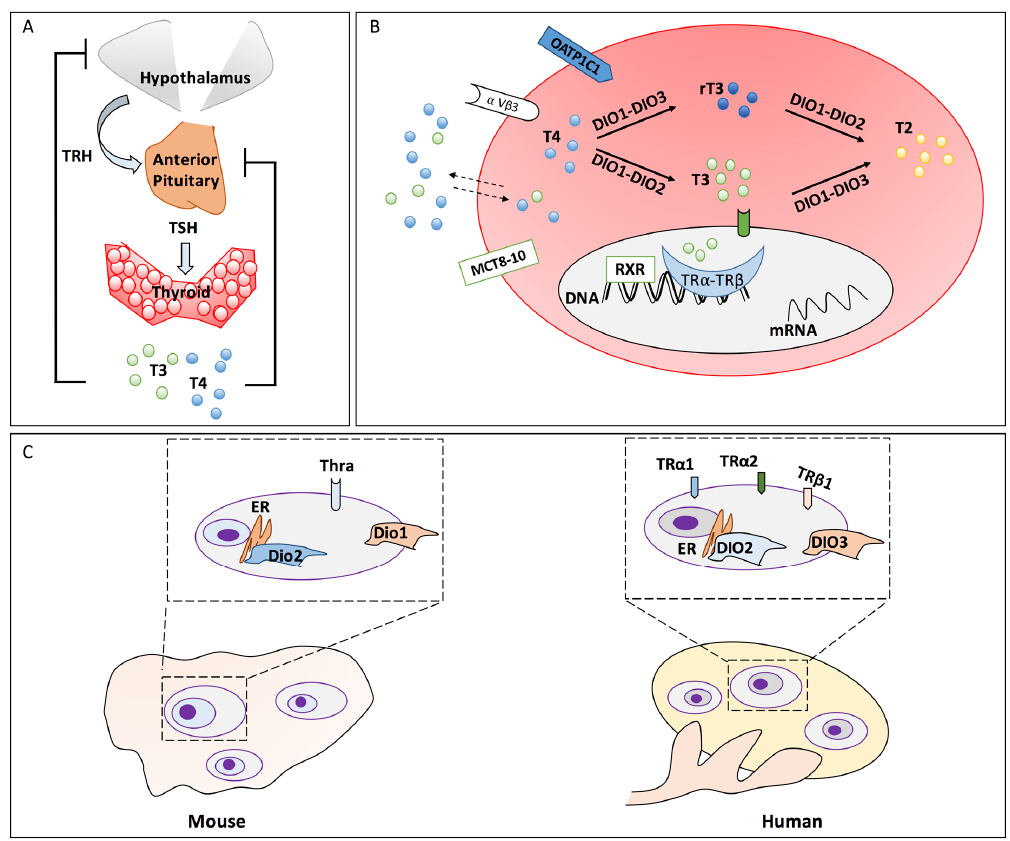
Figure 1. HPT-axis and peripheral TH metabolism / signalling in mammals. ( A ) Hypothalamic-Pituitary-Thyroid (HPT)-axis and its regulatory feedback loops. ( B ) Mechanisms/enzymes and other proteins involved in the cell/tissue-specific TH metabolism and signalling. ( C ) Description of the species-specific pattern of the ensemble of proteins involved in TH metabolism and signalling in the ovary. The ovarian follicles are evidenced in the dashed rectangles. The zoom on a single follicle is reported in the upper dashed box in order to evidence the ensemble of the expressed proteins involved in peripheral TH metabolism and signalling. Abbreviations: TRH, thyrotropin releasing hormone; TSH, thyroid-stimulating hormone; T4, thyroxine; T3, triiodothyronine; T2, 3,5-diiodo-L-thyronine; rT3, reverse triiodothyronine; DIO1, DIO2, DIO3, deiodinases; MCT8–10, monocarboxylate transporter 8–10; OATP1C1, organic anion transporting polypeptide 1C1; α V β 3, integrin alpha (V) beta (3); TR α and TR β , thyroid nuclear receptors isoform α , β ; RXR, retinoic acid X receptor; ER, endoplasmic reticulum; Thra, thyroid hormone receptor alpha (Mouse); TR α 1, TR α 2, TR β 1 thyroid hormone receptors isoform α 1, α 2, β 1 (Human). The thyroid gland releases mainly the pro-hormone T 4 and to a lesser extent T 3 , the biologically more active form of THs. Their synthesis requires the activity of a complex network of thyroid- specific enzymes. Briefly, iodine entry in thyroid follicular cells is mediated by two glycoproteins: sodium-iodide symporter (NIS) and pendrin [11,12]. The iodine oxidation is mediated by thyroid peroxidase (TPO) and, finally, it is incorporated into the thyroglobulin (TG) by a multistep process leading to the formation of T 4 . The prohormone T 4 is converted to bioactive T 3 (or to inactive rT 3 ) in the thyroid and, mainly, in peripheral tissues by the deiodinases (Dio1, Dio2 and Dio3) [13–15]. Dio2 and Dio1 are T 4 /T 3 activating enzymes and cooperate to maintain THs homeostasis, due to their differential expression in response to THs availability. Noteworthy, Dio2 regulates intracellular T 3 and increases in hypothyroid subjects [16], whereas Dio1 regulates mainly circulating THs [17]. However, Dio1 can also inactivate T 4 to rT 3 and the sulfonated THs participating in the defence